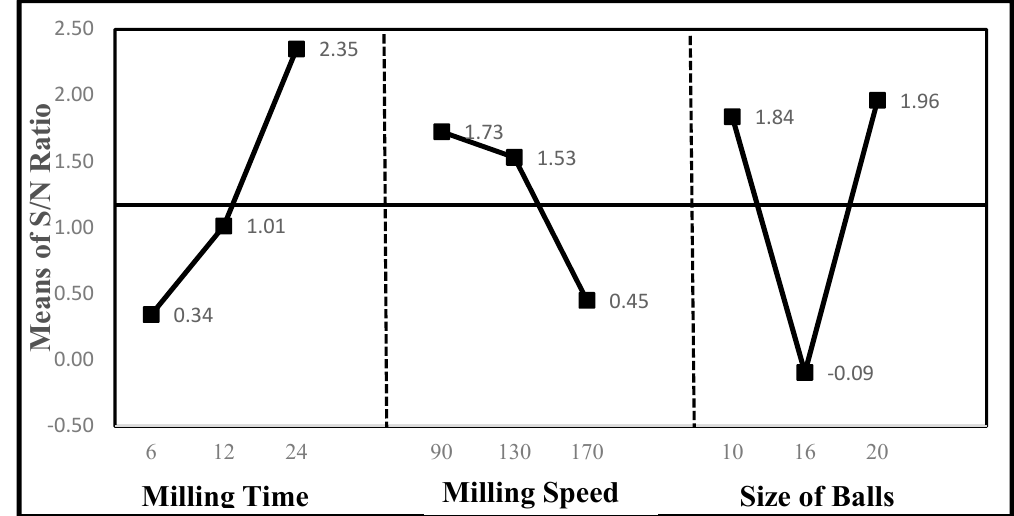
Figure 6. Main effects of S/N ratio for POA particles size versus the level of input parameters. Figure 6. Main e ff ects of S / N ratio for POA particles size versus the level of input